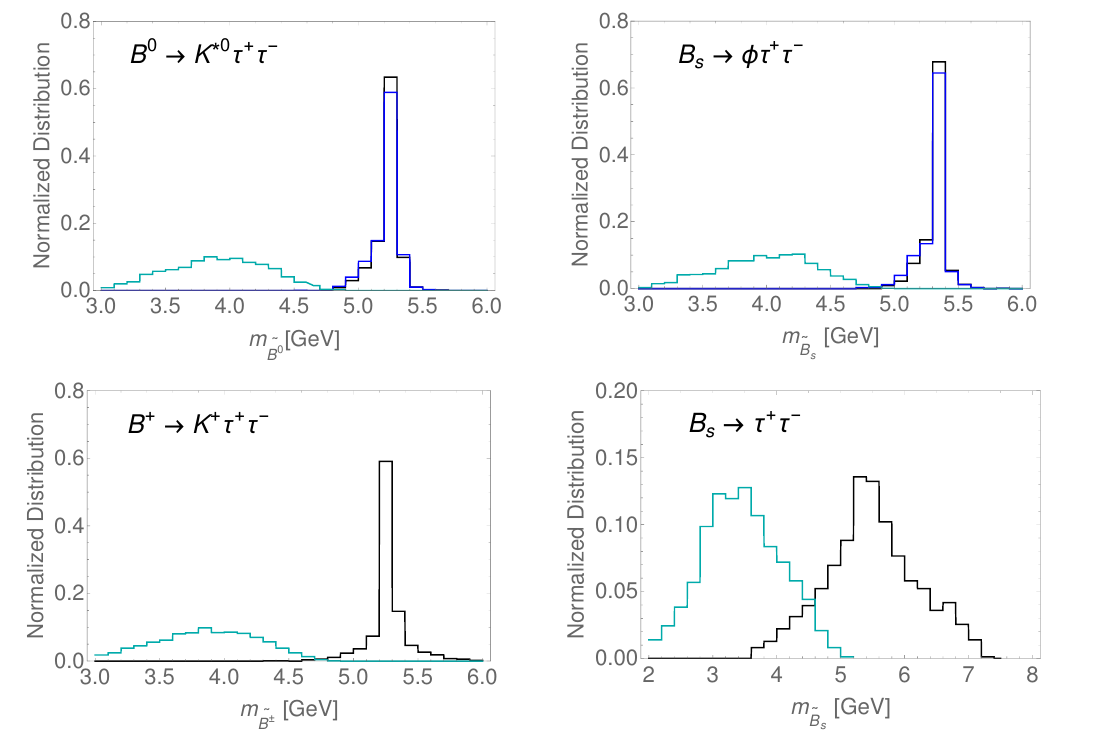
Figure 2 . Normalized mass distributions of the reconstructed B mesons. The cyan curves, repre- senting the invariant mass of the charged particles from the B -meson decays, serve as a reference. The blue curves in the upper panels result from an intermediate reconstruction, i.e., solving the equations in eq. (2.1). The black curves are obtained from the full reconstruction by minimizing the reconstruction error (cid:15)